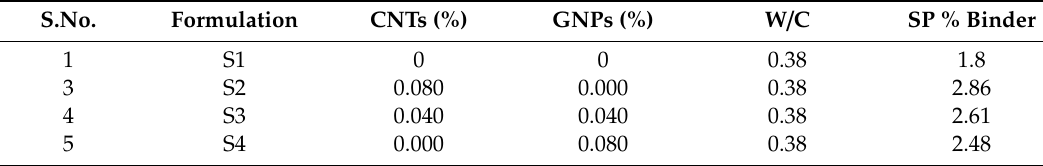
Table 7. List of self-compacting cementitious system (SCCM).